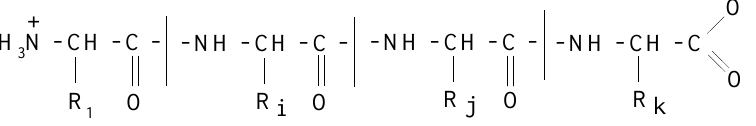
Scheme 1. The structural formula of the gelatin .